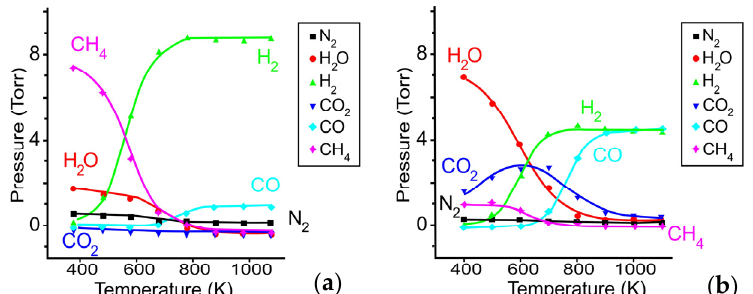
Figure 2. Partial pressures of volatile species versus tempe r ature for the Mg(tmeda)(thd) 2 precursor decomposed in vacuum ( a ) and in oxygen ( b ). Adapted with permission from [14]. Copyright 2020 American Chemical Society.